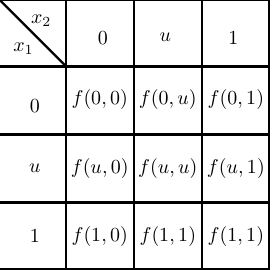
Figure 2. Example of a three-element